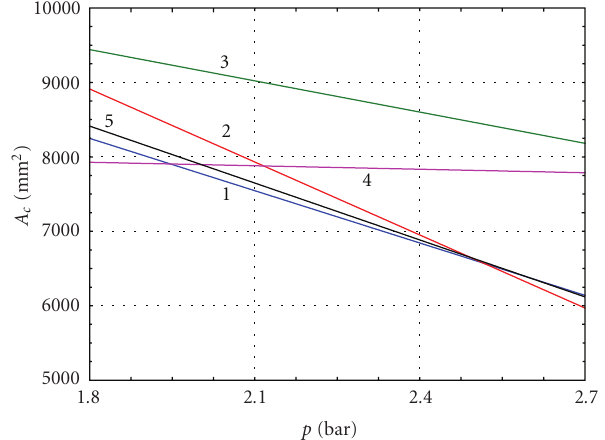
Figure 9: Average contour pressure (for total range of normal load) as a function of